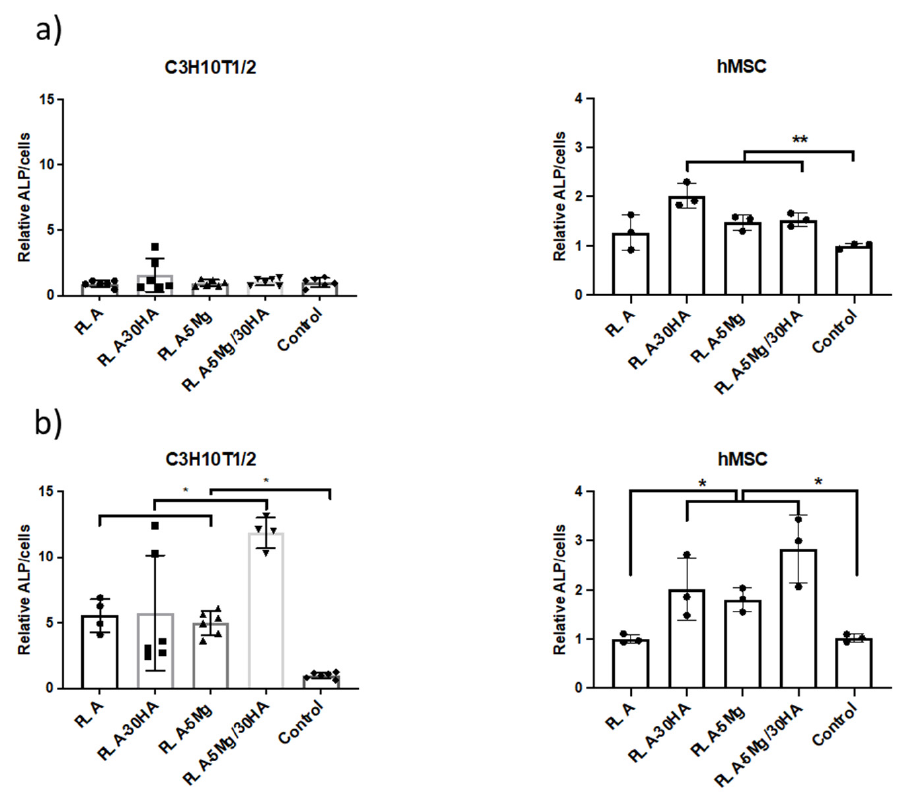
Figure 8. ALP osteogenic differentiation marker activity measurement 7 days after cell-seeding . ALP measurement after 7-day cell culture in normal media ( a ). ALP measurement after 7-day induction of cell-differentiation with osteogenic media ( b ). ( n = 3 replica per surface).